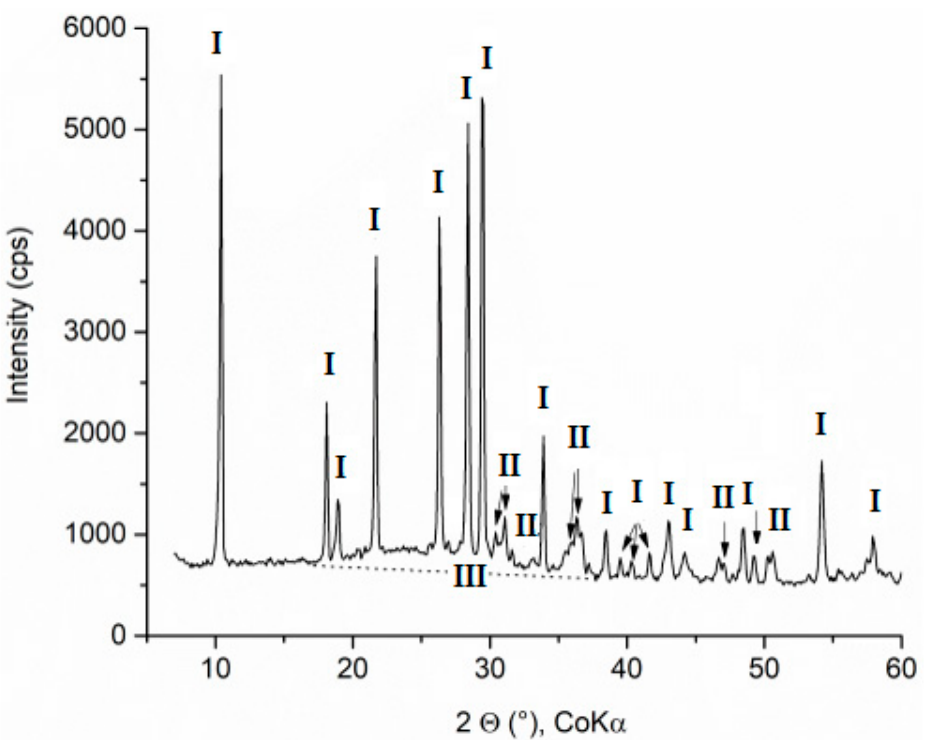
Figure 2. X-ray diffraction (XRD) pattern of the ceramic CCS. I, cordierite I; II, enstatite; dotted line separates a non-crystalline phases III area from the background.